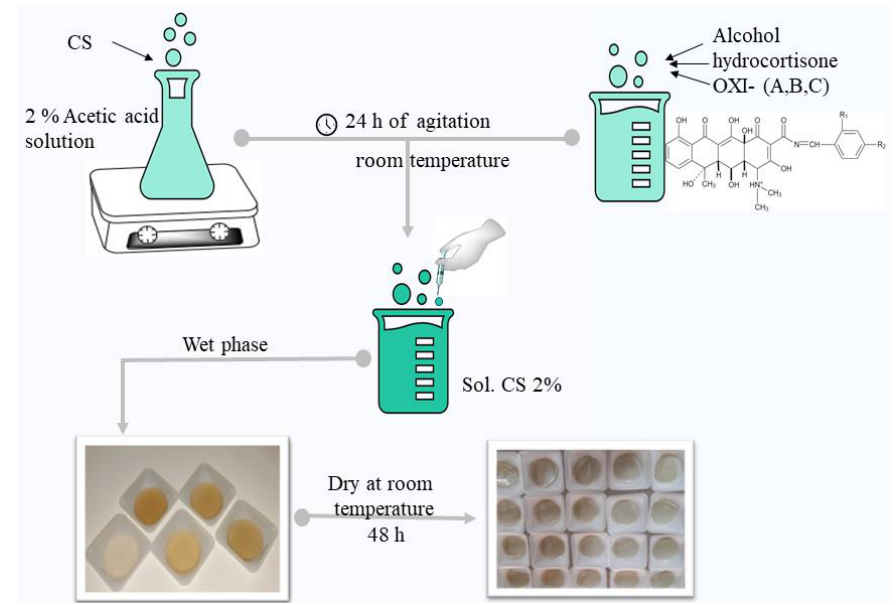
Figure 1. The stages of obtaining CS-OXI derivative film type membranes.